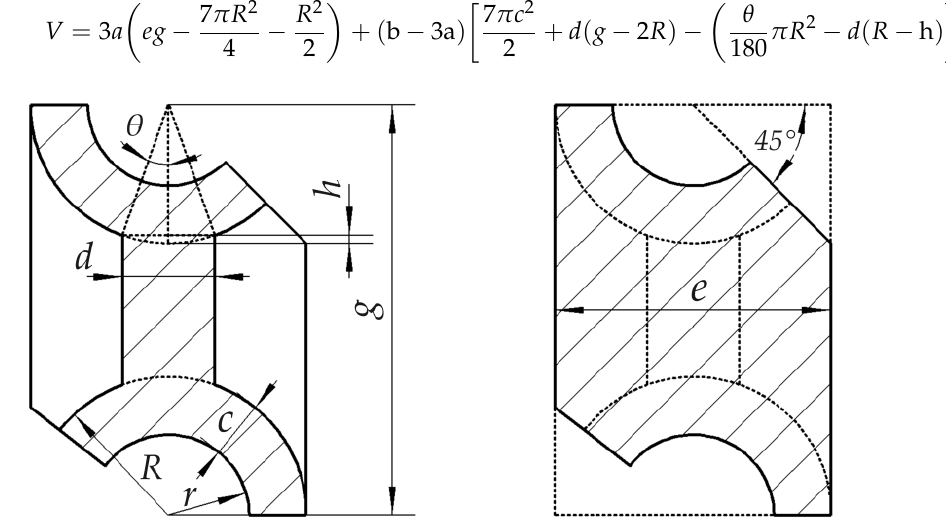
Figure 17. Cross-section of drive rod.